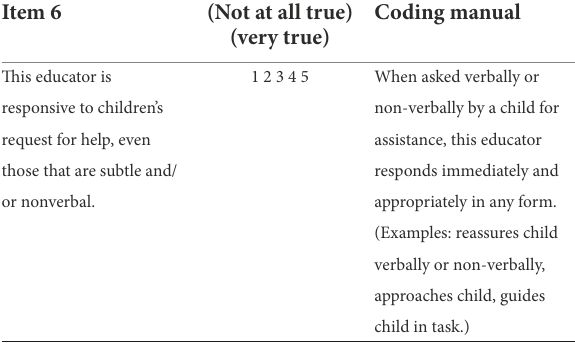
TABLE 1 Examples of project content, scoring methods and operation